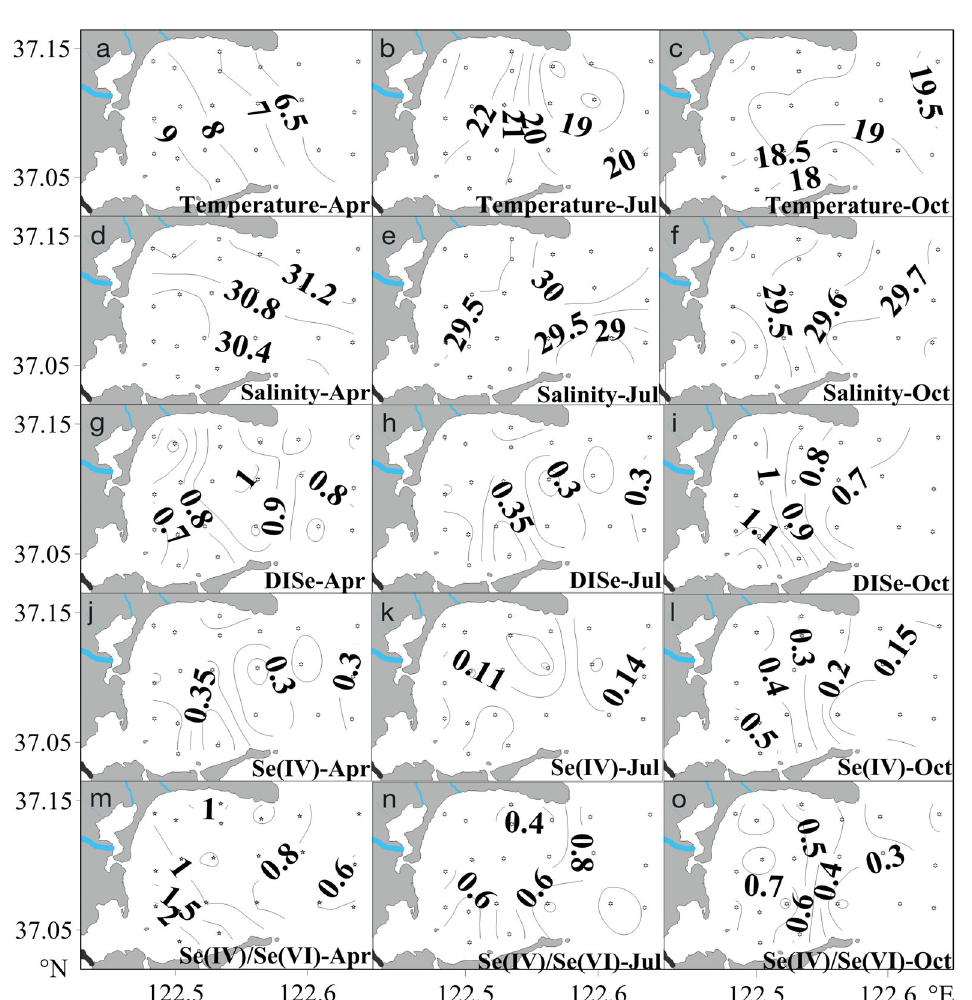
Fig. 2. (a−c) Temperature, (d−f) salinity, (g−i) dissolved inorganic selenium (DISe) concentration, (j−l) Se(IV) concentration and (m−o) Se(IV)/Se(VI) ratio distributions at the surface of Sanggou Bay in April, July, and October 2013 (left, centre and right columns, respectively) Table 1. Mean values (with ranges in parentheses) of temperature, salinity, chl a , dissolved inorganic selenium (DISe) and Se(IV) concentration